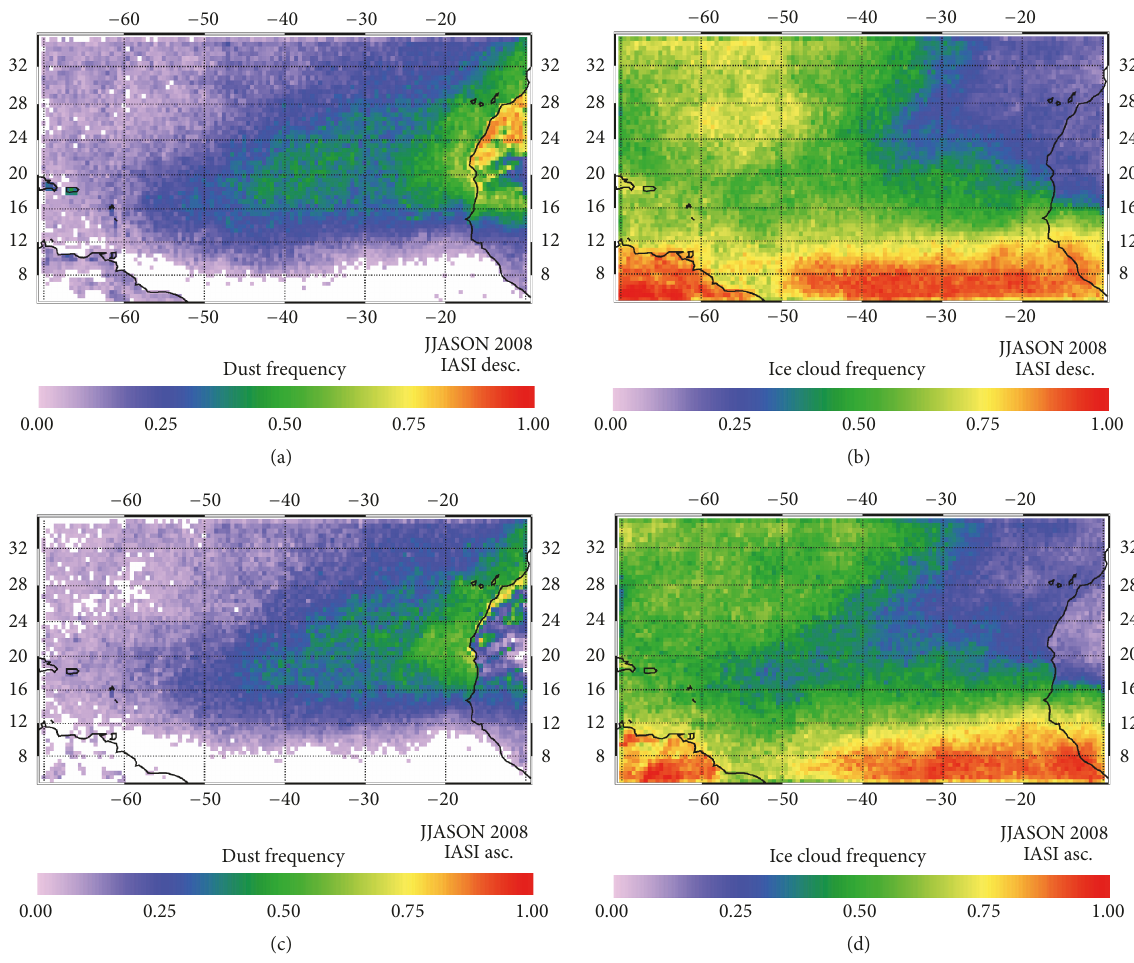
Figure1:Observationfrequencyofdesertdust(a,c)andiceclouds(b,d)obtainedfromIASIdescending(a,b)andascending(c,d)overpasses with the IMARS retrieval for the hurricane season 2008 over the tropical North Atlantic